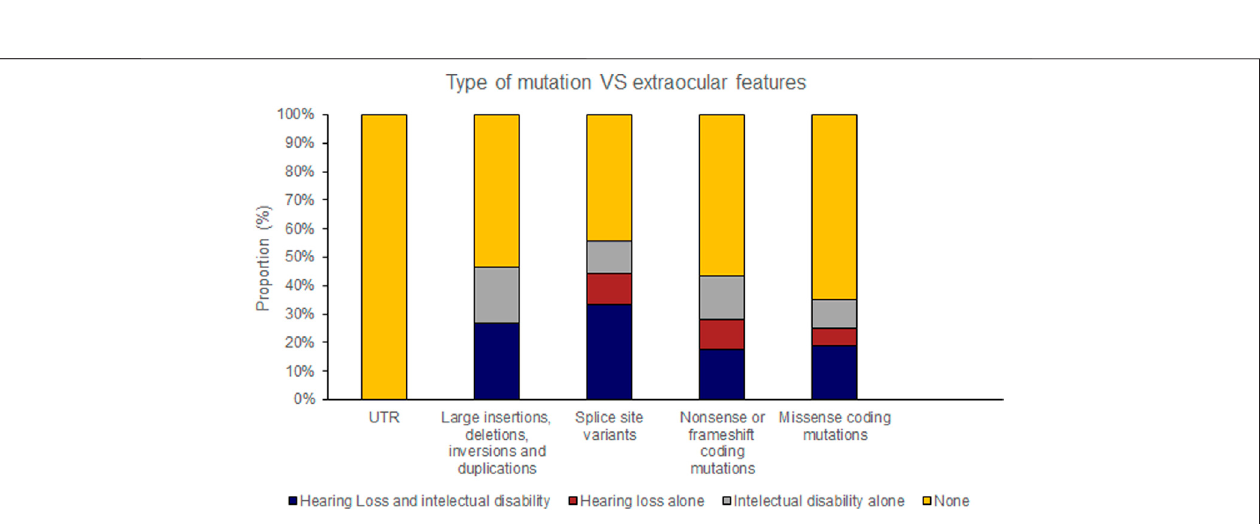
FIGURE 6 | Missense mutations within the NDP coding DNA were classi fi ed by the functional region of the NDP protein affected. The proportion of mutations of each type that causes either ‘ severe ’ or ‘ moderate ’ retinopathy is shown.